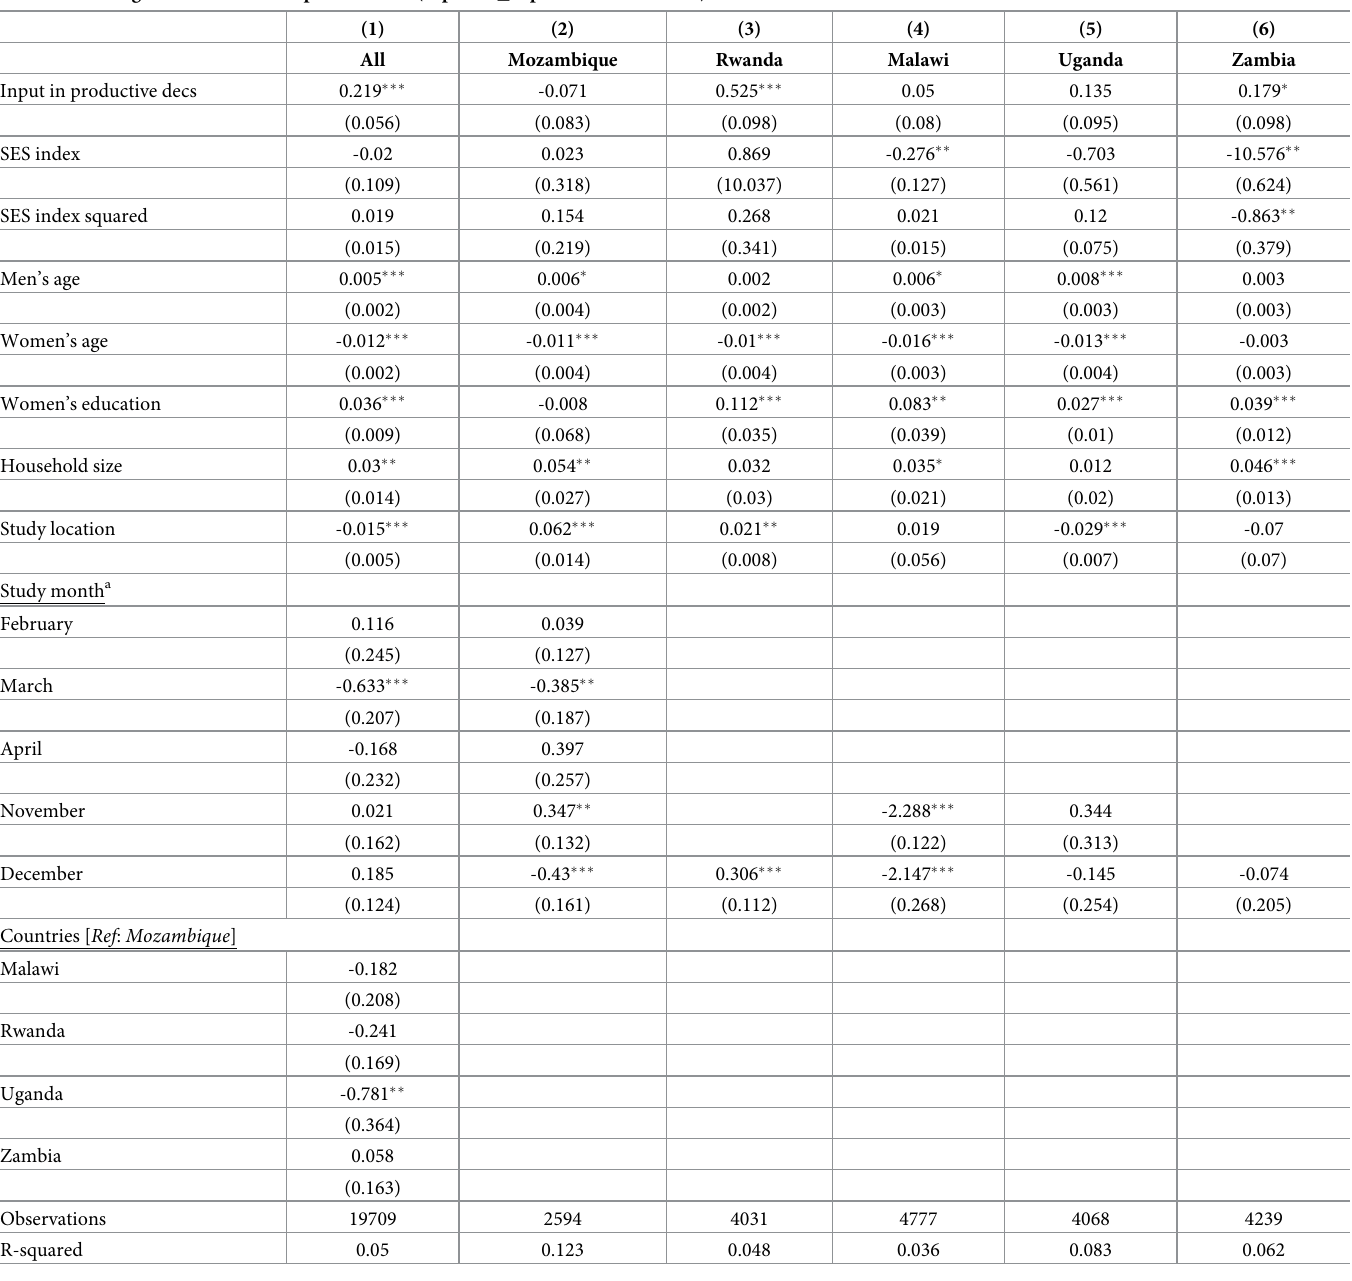
Table 6. OLS regression for WDDS–prod domain (Input in � 2 productive